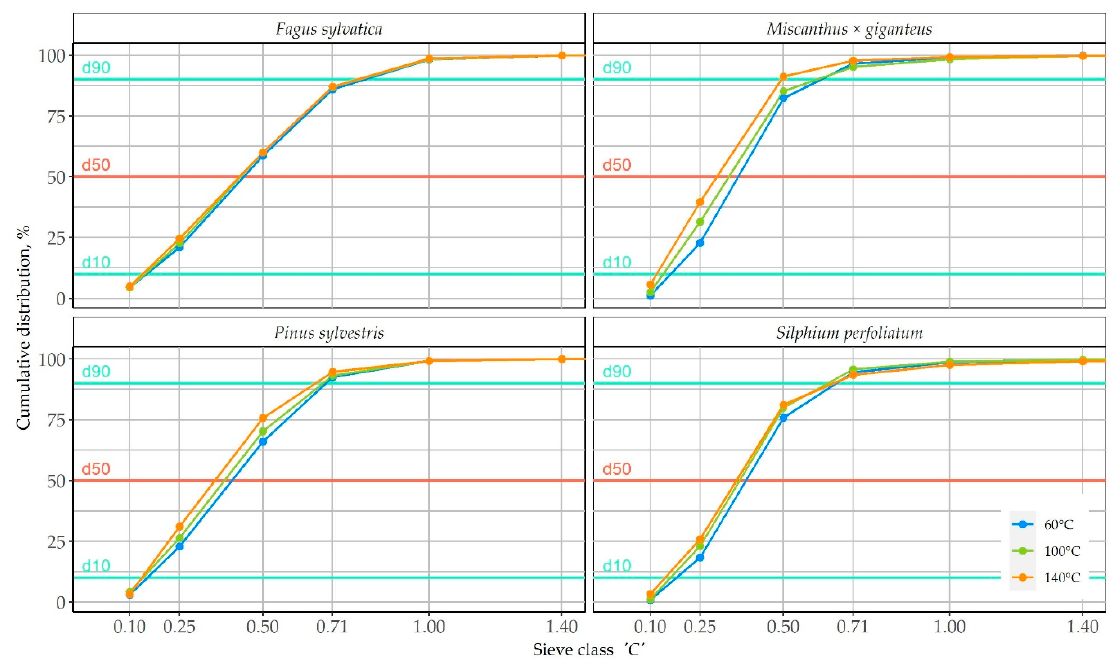
Figure 3. Cumulative particle size distribution (cPSD) raw materials ground with the knife milling system.